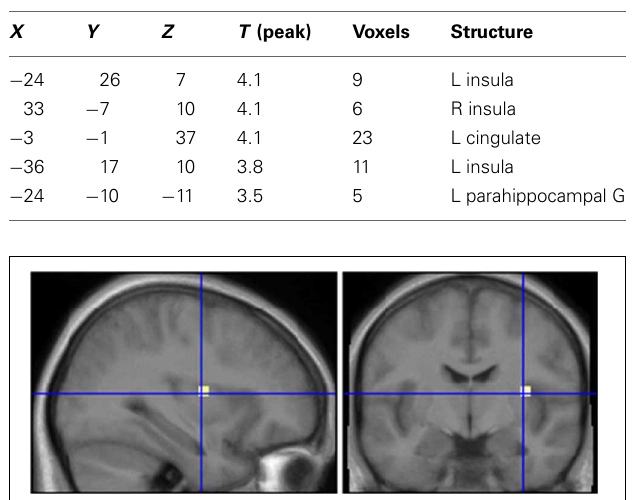
FIGURE 3 | Comparison of subjects who smell ambroxan and subjects who don’t after stimulation with ambroxan. Area in cross hairs: right